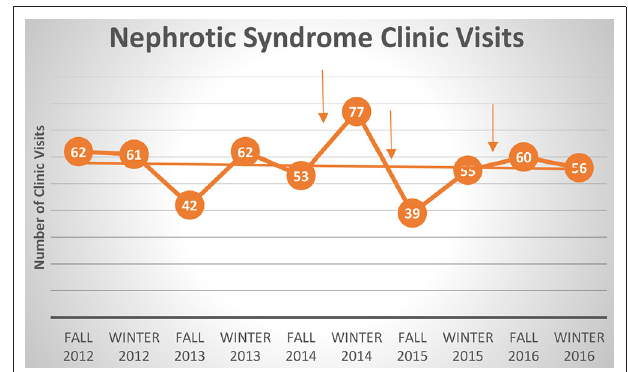
FIGURE 3 | Clinic visits for nephrotic syndrome. Each arrow indicates time of PDSA cycle. Best fit line shows overall no change in clinic visits with each